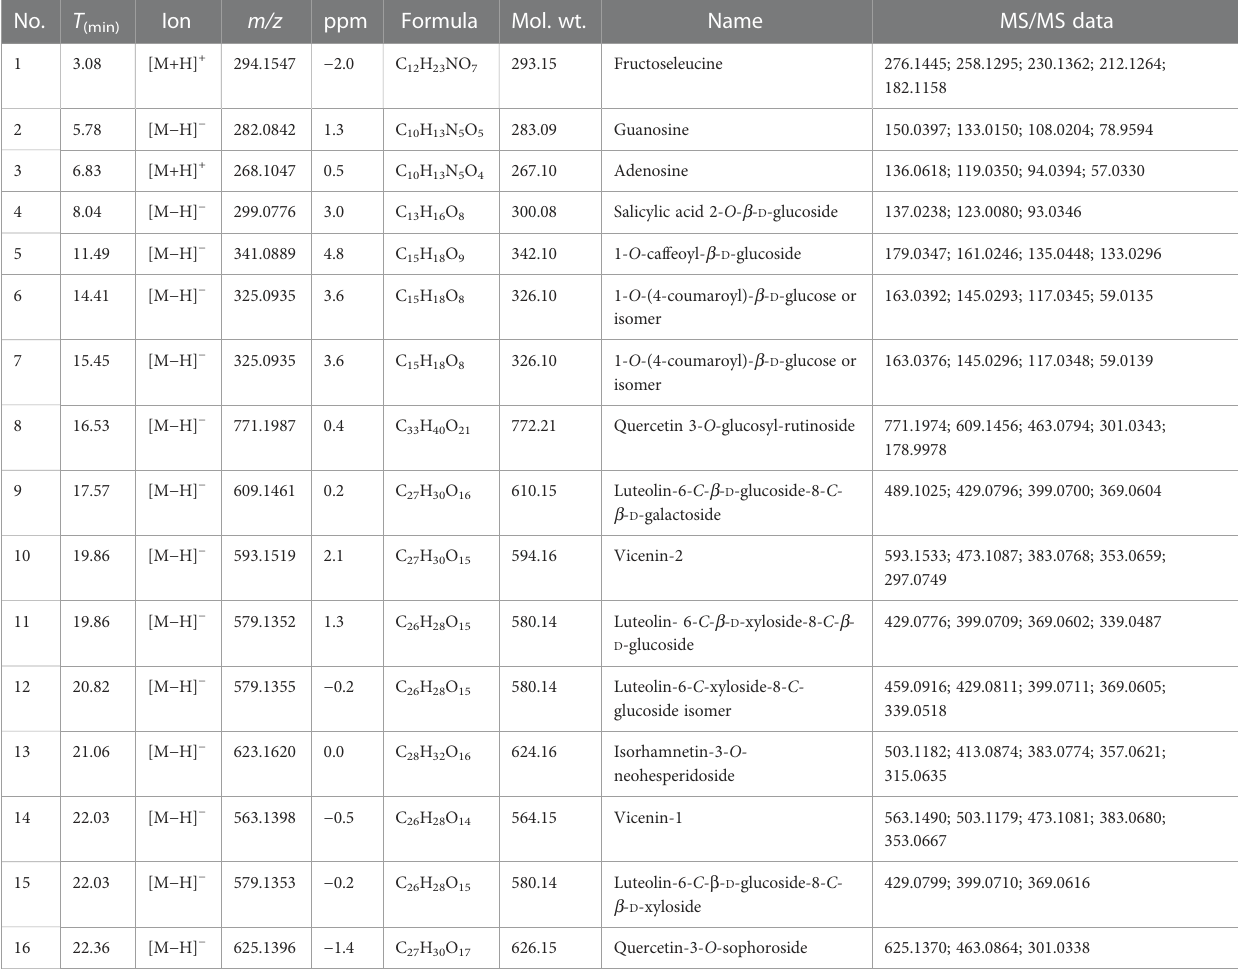
TABLE 1 The physical properties of the identi fi ed compounds from the fl owers of Dendrobium of fi cinale . No.